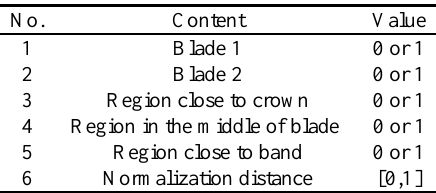
Table 1. Output unit